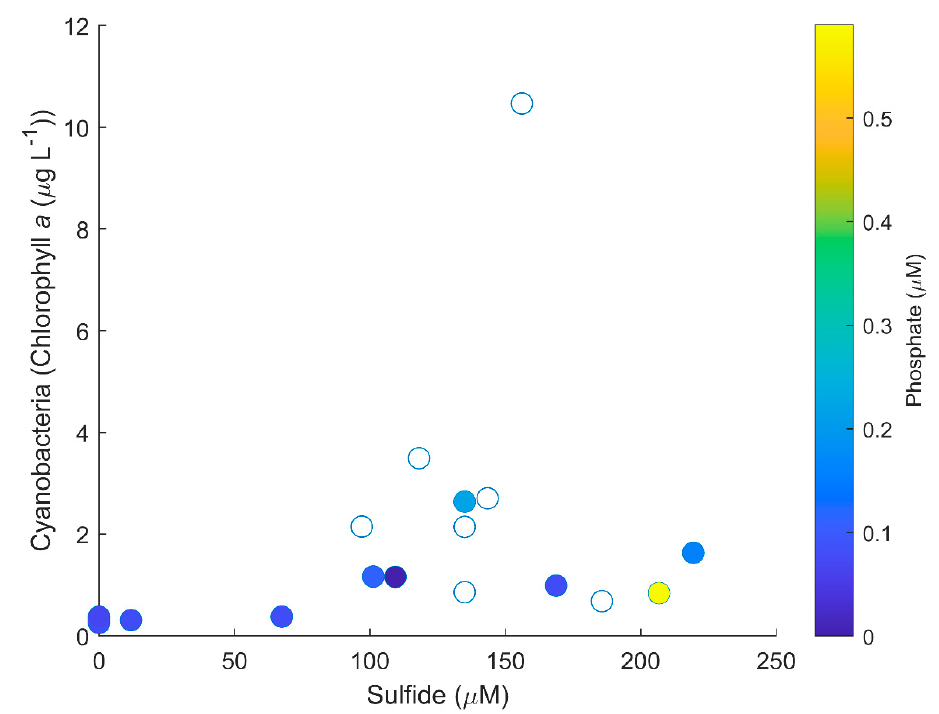
Figure 5. Cyanobacteria ( Oscillatoria sp.) concentration versus sulfide concentration plot. Phosphate concentration is shown using a color scale with filled symbols. Open circles indicate weekly samples where no nutrient measurements were carried out.